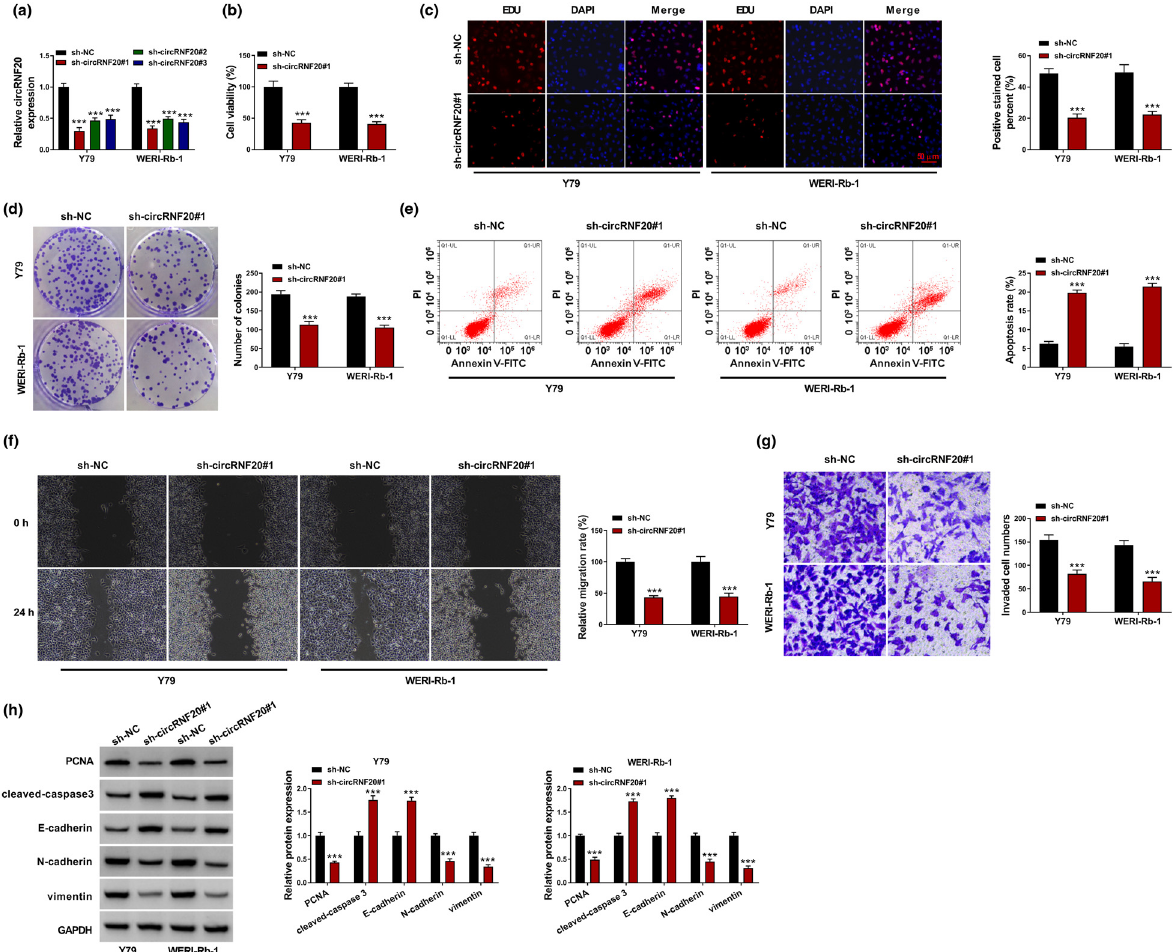
Figure 2: E ff ects of circRNF20 knockdown on RB cell proliferation, apoptosis, migration and invasion. ( a ) The expression of circRNF20 in Y79 and WERI - Rb - 1 cells transfected with sh - NC, sh - circRNF20#1, sh - circRNF20#2 and sh - circRNF20#3 was detected by qRT - PCR assay. ( b – h